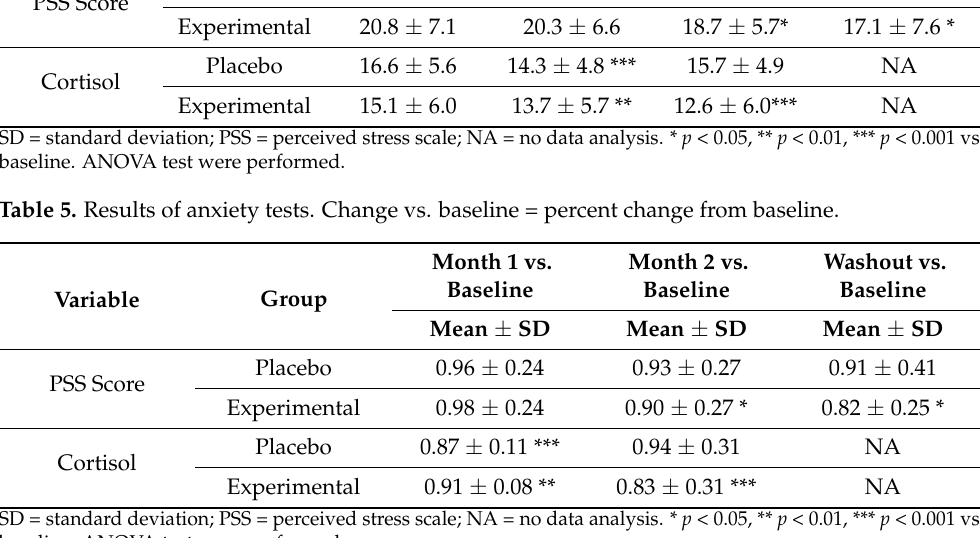
Table 4. Chart depicting values; anxiety tests. Baseline Month 1 Month 2 Washout Variable Group